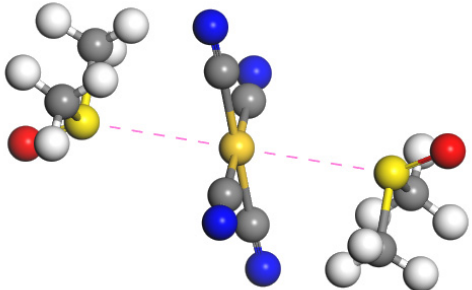
Figure 5. The structure of the most stable gold(III) tetracyanide: dimethyl sulfide (1:2) complex isomer, [Au(CN) 4 DMSO 2 ] − κ -S, S. Atom coloring: Au—gold, C—grey, N—blue, S—yellow, O—red, and H—white. The pink dashed line represents close contact between Au and S atoms. Although the stabilizing interactions between the additional ligands, DMSO molecules, and gold(III) tetracyanide are being formed, the presented complex is not stable due to the entropic penalty resulting in the positive value of free enthalpy of formation. The results of the calculations indicate the preference of the κ -S, S isomer. However, unexpectedly, the κ -S, O isomer was found to be the least stable one. Similarly, as in the case of mono DMSO complexes, the formation of the studied molecules is energetically favorable due to the formation of the intermolecular interactions between the positively charged Au(III) and DMSO, which is the Lewis base. However, due to the decrease of entropy resulting from such complexation, the formation of both mono and di DMSO complexes is not preferable thermodynamically due to the positive ∆ G of such